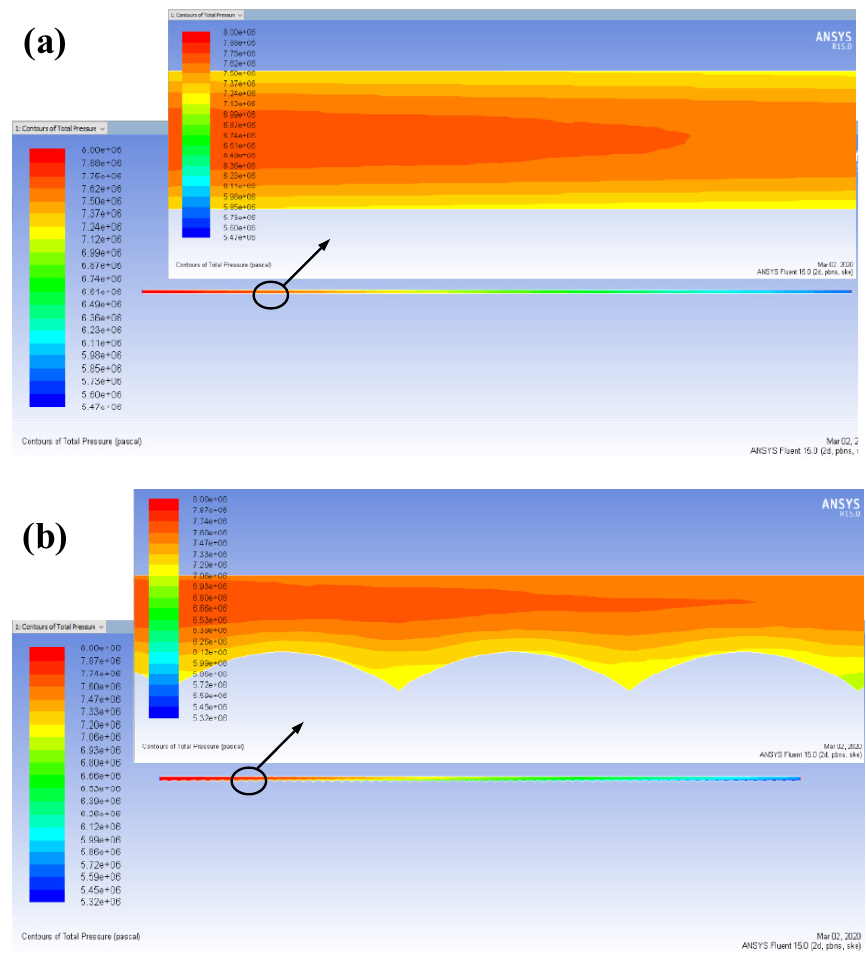
Figure 17. ( a ) The pressure distribution on smooth parallel disk damping gap, ( b ) the pressure distribution on turning parallel disk damping gap. distribution on turning parallel disk damping